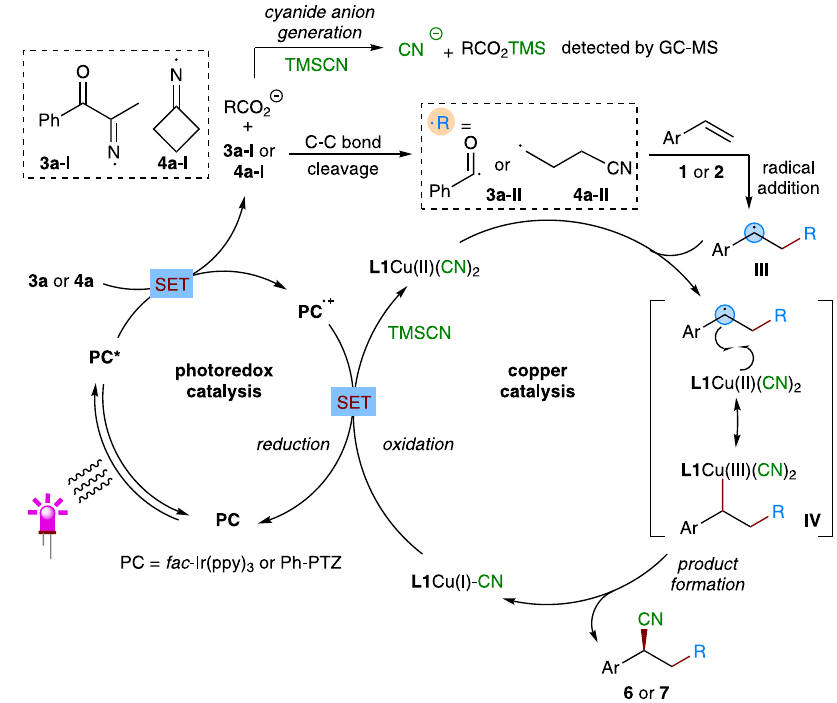
Fig. 8 Proposed reaction mechanism. SET single-electron and its Supplementary Information fi les. X-ray structural data of compounds 6bj and 7ja are available free of charge from the Cambridge Crystallographic Data Center under the deposition number CCDC 2047031 ( 6bj ) and 2047032 ( 7ja ). These data can be obtained free of charge from The Cambridge Crystallographic Data Center via www.ccdc.cam.ac. uk/data_request/cif.